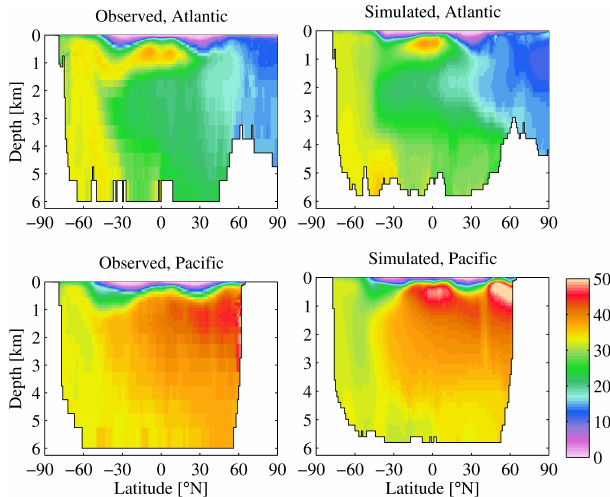
Fig. 8. Intercomparison of observational (left) and model (right) fields of zonally averaged dissolved inorganic nitrogen for the Atlantic (top) and Pacific (bottom) basins. Concentrations in mmol N m − 3 .